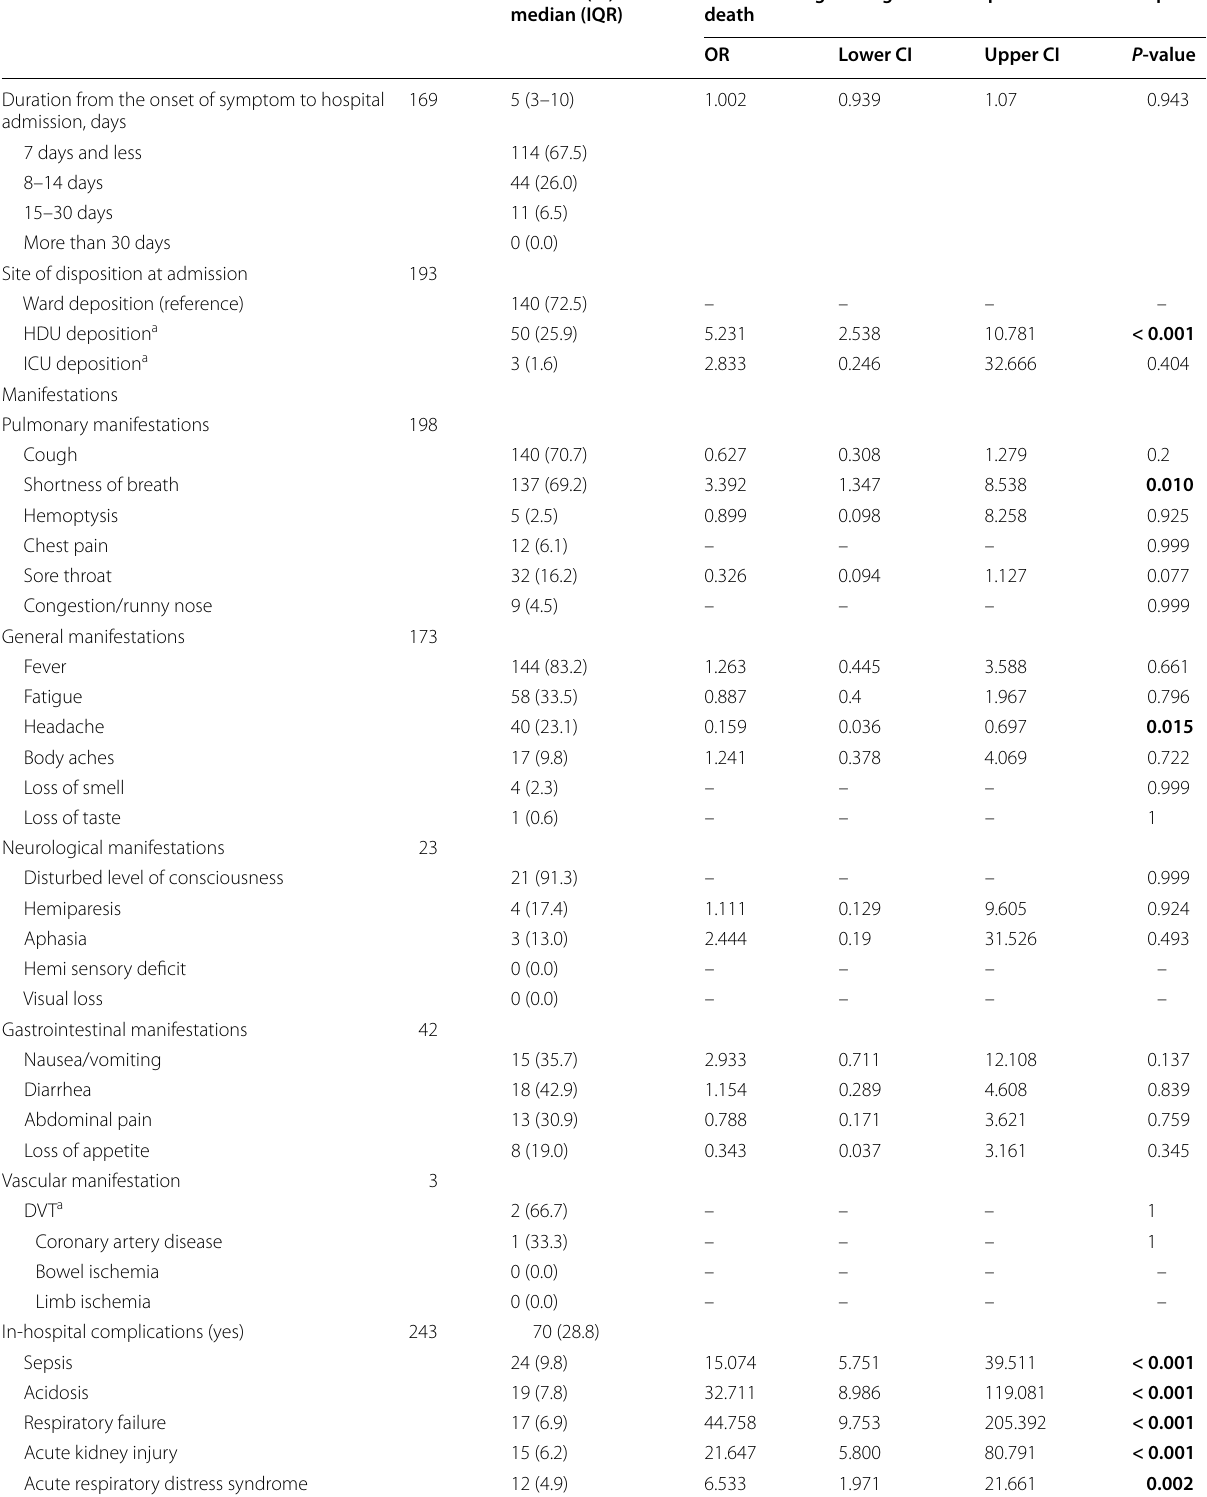
Table 2 Clinical manifestations: symptoms, hospital disposition, complications and severity of patients diagnosed with COVID-19 and their association with the final outcome Variables n Number (%) or